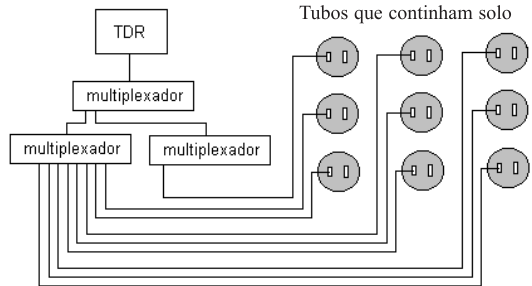
Figura 1. Disposição das guias de onda e do equipamento de TDR, com os